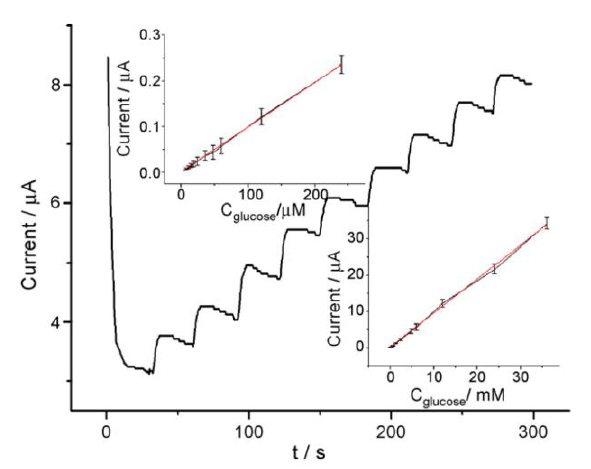
Figure 5. Amperometric response of GOD–HRP/SBA-15 modified GCE upon successive additions of 5  L 0.4M glucose to 5.0 mL 0.1 M pH 7.0 PBS at −0.40 V. Insets (A) and (B): linear calibration curve of glucose sensor with five reduplicate measurements. Reprinted from reference [30] with permission from Elsevier Science